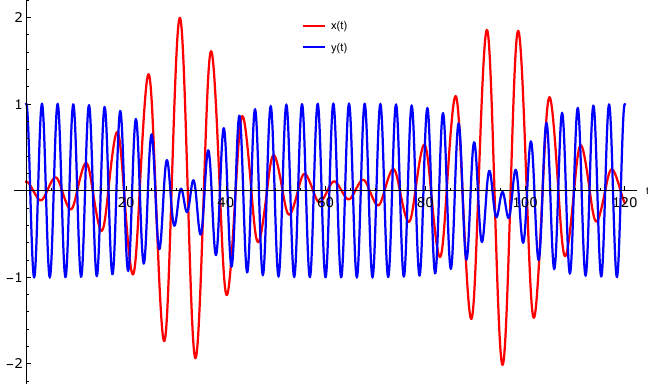
Figure 1. An example of a parametric resonance in a closed system with two modes. The frequencies are chosen ω 1 = 1 and ω 2 = 2, corresponding to parametric resonance, while the mode coupling is q = 0 . 5. Initial conditions for the particular motion shown are x (0) = 0 . 1, y (0) = 1 and ˙ x (0) = ˙ y (0) =